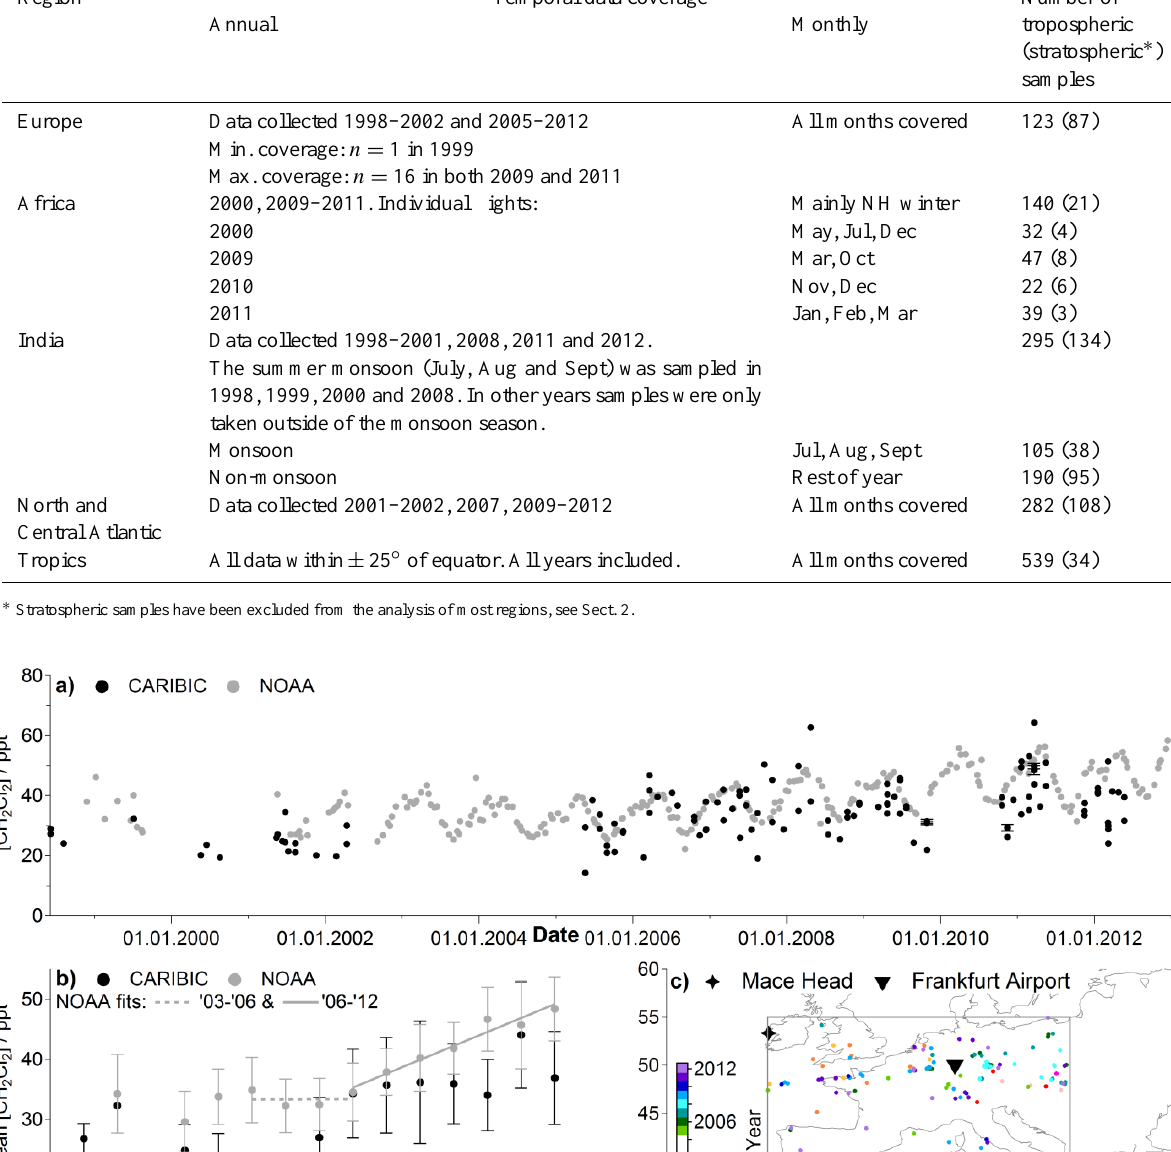
Table 1. A summary of CARIBIC data used in this study. Region